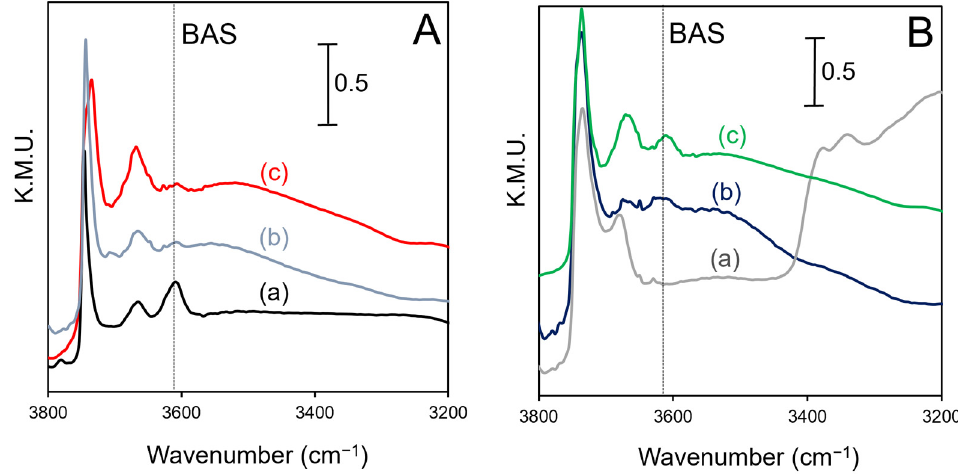
Figure 4. DRIFT spectra in the v OH region of catalysts after in situ pretreatment at 350 °C. ( A ) (a) H- Beta, (b) Ni-H-Beta (H + -1x), (c) Ni-H-Beta (H + -4x); ( B ) (a) NH 4 -Beta, (b) Ni-NH 4 -Beta, (c) Ni-H-Beta (NH 4+ -4x).